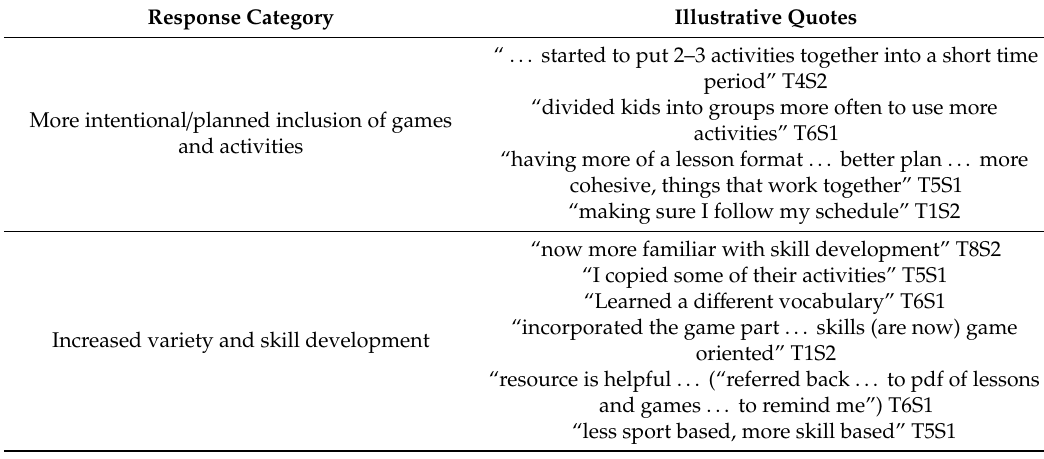
Table 6. Response categories and illustrative quotes from teacher interview content analysis 1